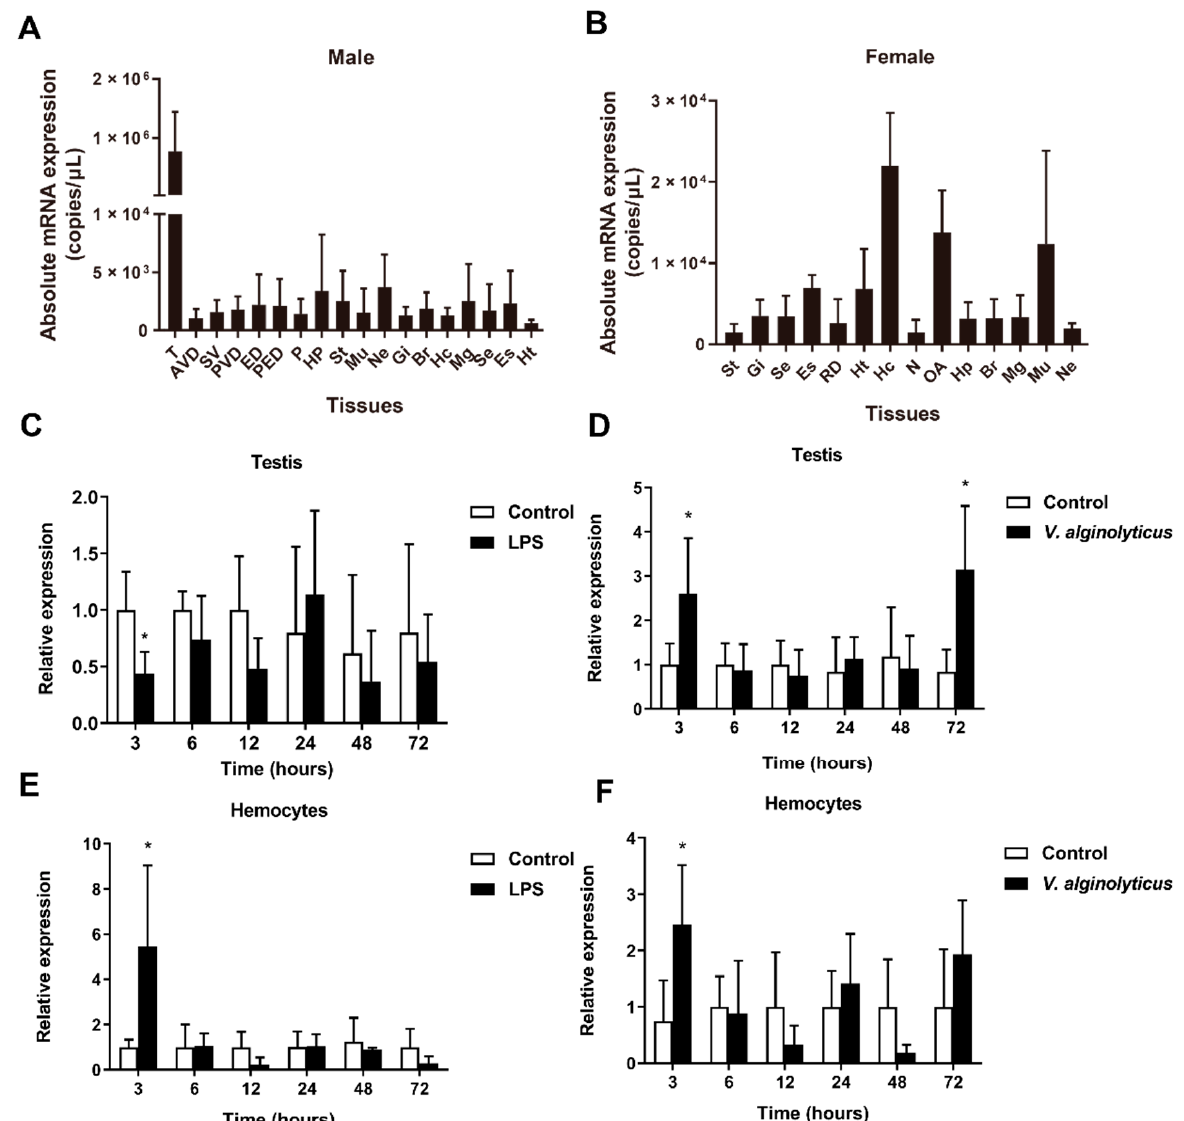
Figure 2. Gene expression profiles of Sparanegtin in S. paramamosain . The expression profile of Sparanegtin in adult male ( A ) and female ( B ) crabs under natural status was determined by absolute qPCR. Data are presented as mean ± standard deviation (SD). The relative expression of Sparanegtin in male testes after LPS ( C ) and V. alginolyticus ( D ) challenges, and in male hepatopancreas after LPS ( E ) and V. alginolyticus ( F ) challenges was examined. In panel ( C – F ), data are presented as mean ± SD. * p < 0.05, one-way analysis of variance (ANOVA) and Bonferroni post-test. Abbreviations: T, testis; AVD, anterior vas deferens; SV, seminal vesicle; PVD, posterior vas deferens; ED, ejaculatory duct; PED, posterior ejaculatory duct; P, penis; OA, ovary; N, spermathecae; RD, reproductive duct; Mu, dermis; Es, eye stalk; Ht, heart; Hp, hepatopancreas; St, stomach.